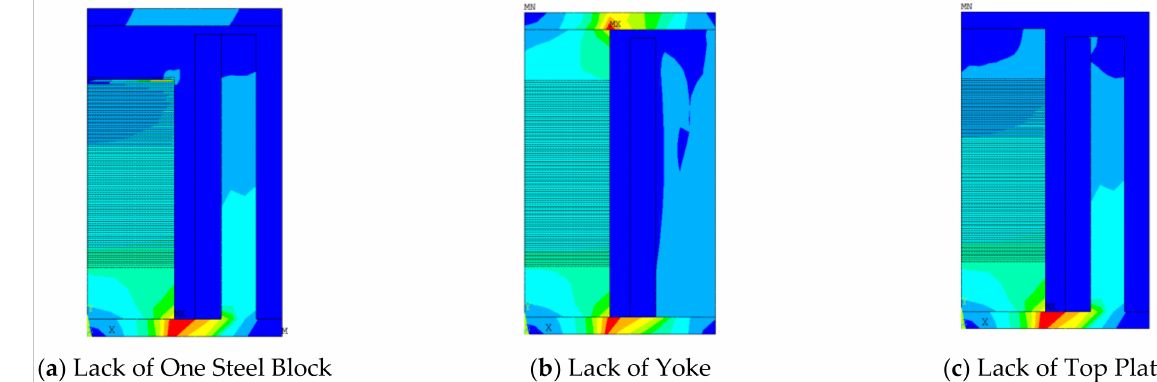
Figure 13. Incomplete Design.